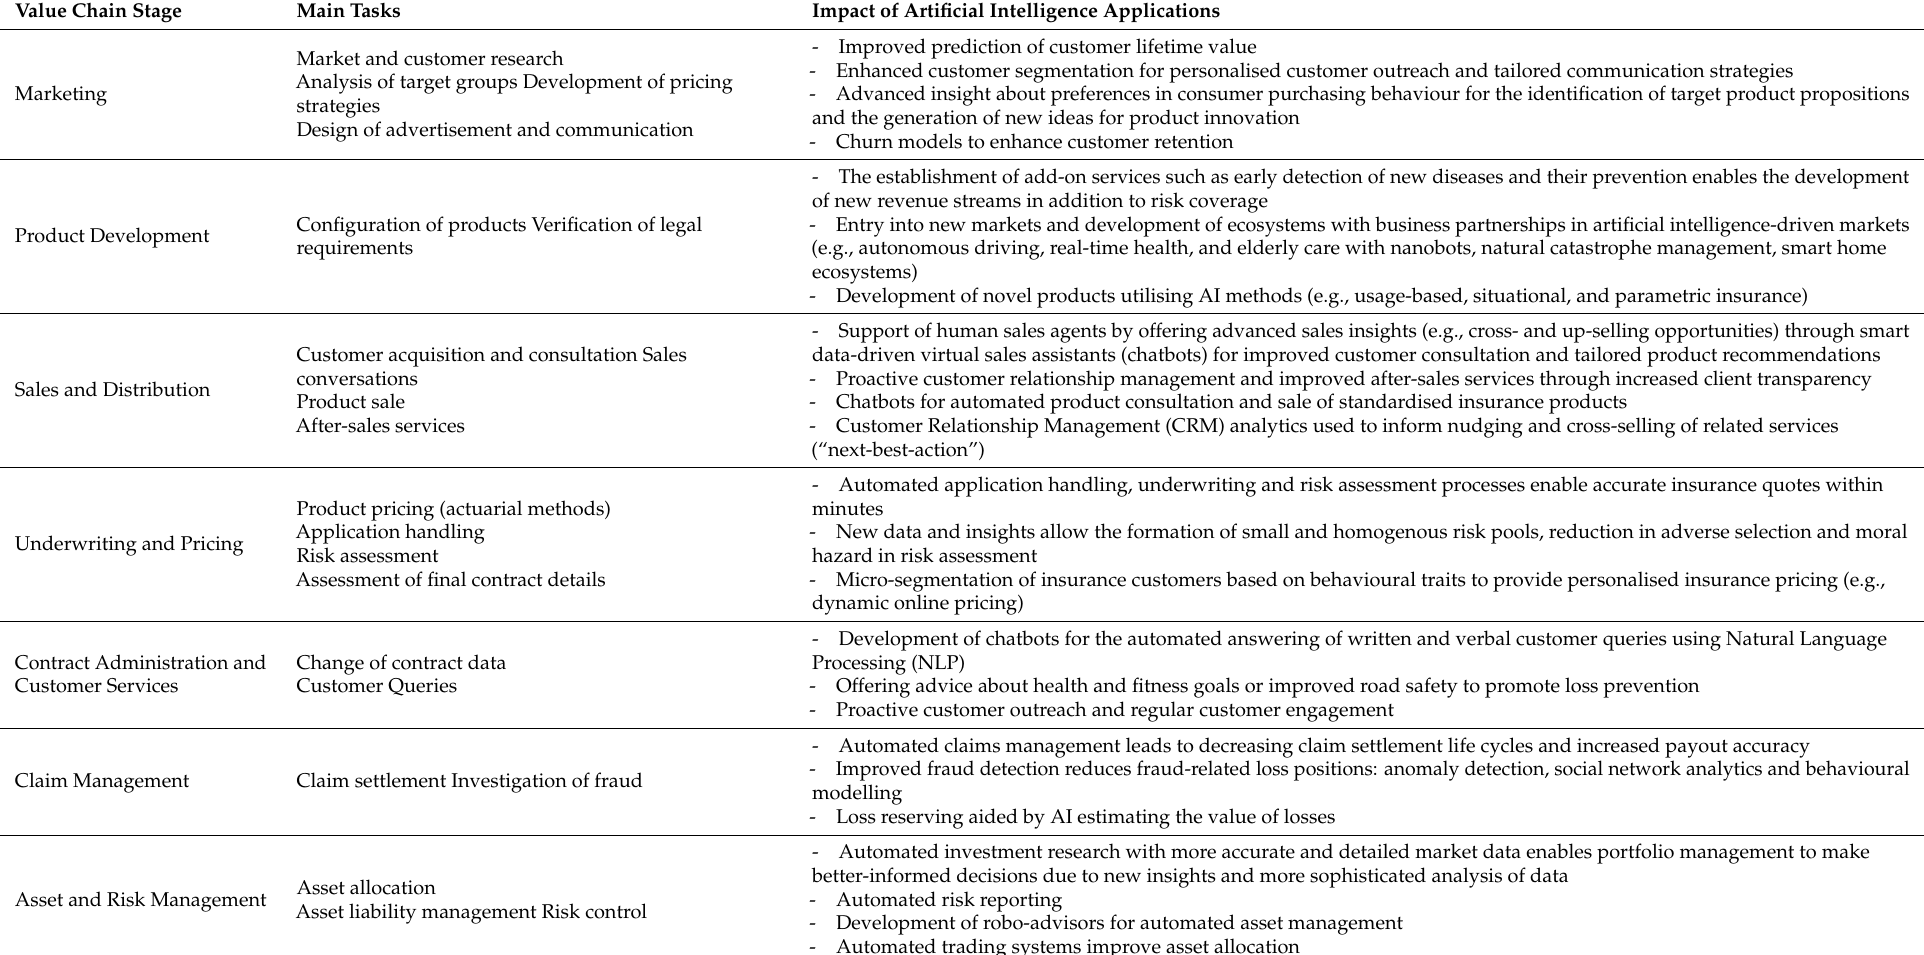
Table 3. The Insurance Value Chain. The stages of the insurance industry’s IVC is adapted from Grize et al. (2020); Eling et al. (2021) and EIOPA